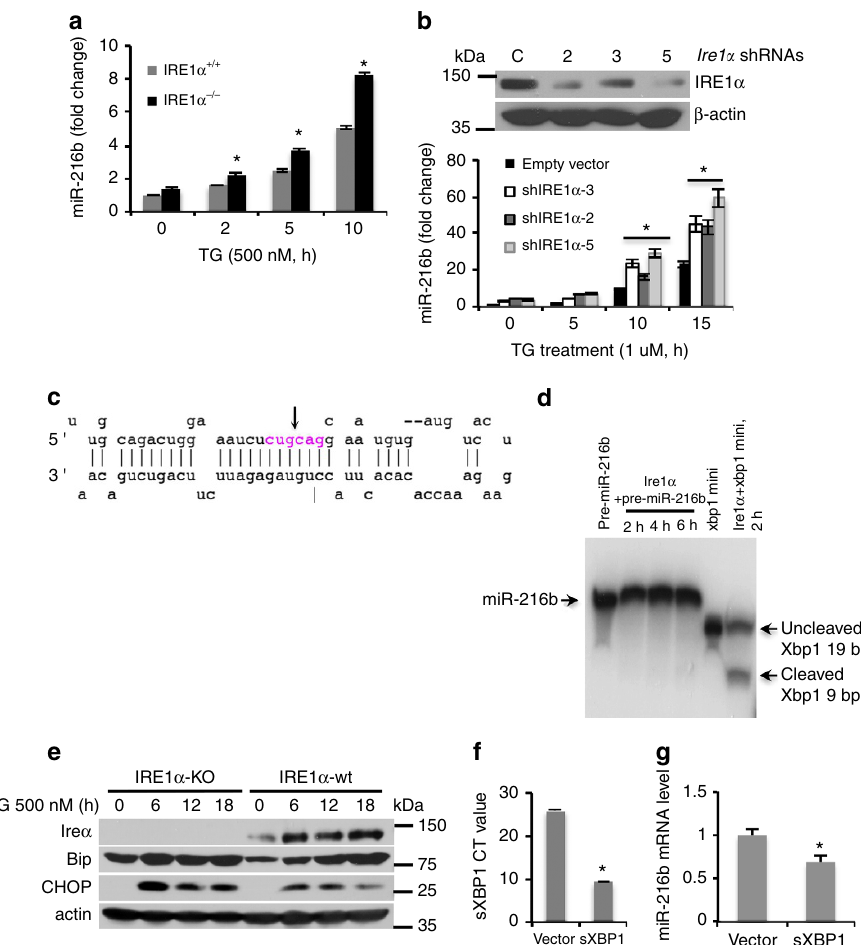
Figure 4 | Ire1 a suppresses miR-216b expression. ( a ) Ire1 a (cid:2) / (cid:2) and Ire1wt MEFs were treated with 500nM TG and miR-216b (right) was measured by qPCR. N ¼ 3. ( b ) Ire1 a was knocked down using three independent shRNAs 2, 3, 5 followed by treatment of cells with 500nM TG. Ire1 a knockdown was confirmed by immunoblot, and miR-216b levels were quantified by qPCR. ( c ) Illustration of the potential Ire1 a cleavage sites within pre-miR-216b. ( d ) g - 32 PATP-labelled pre-miR-216b or Xbp-1 oligonucleotides were incubated with recombinant protein Ire1 a (aa 465–977) for 2, 4 and 6h, and cleavage products were resolved by a urea-polyacrylamide gel electrophoresis and visualized by autoradiography. ( e ) Ire1 a (cid:2) / (cid:2) and Ire1wt MEFs were treated with TG (500nM) for indicated intervals. Ire1 a , Bip and CHOP were assessed by immunoblot. ( f ) Xbp1s expression and ( g ) miR-216b levels in U2OS cells transfected with vector or Xbp1s were quantified by qPCR following exposure of cells to thapsigargin. All panels provide values that are the average of three independent experiments and error bars indicate standard deviation among all the replicates. Statistical analysis was analysed by Student’s t -test (* P o